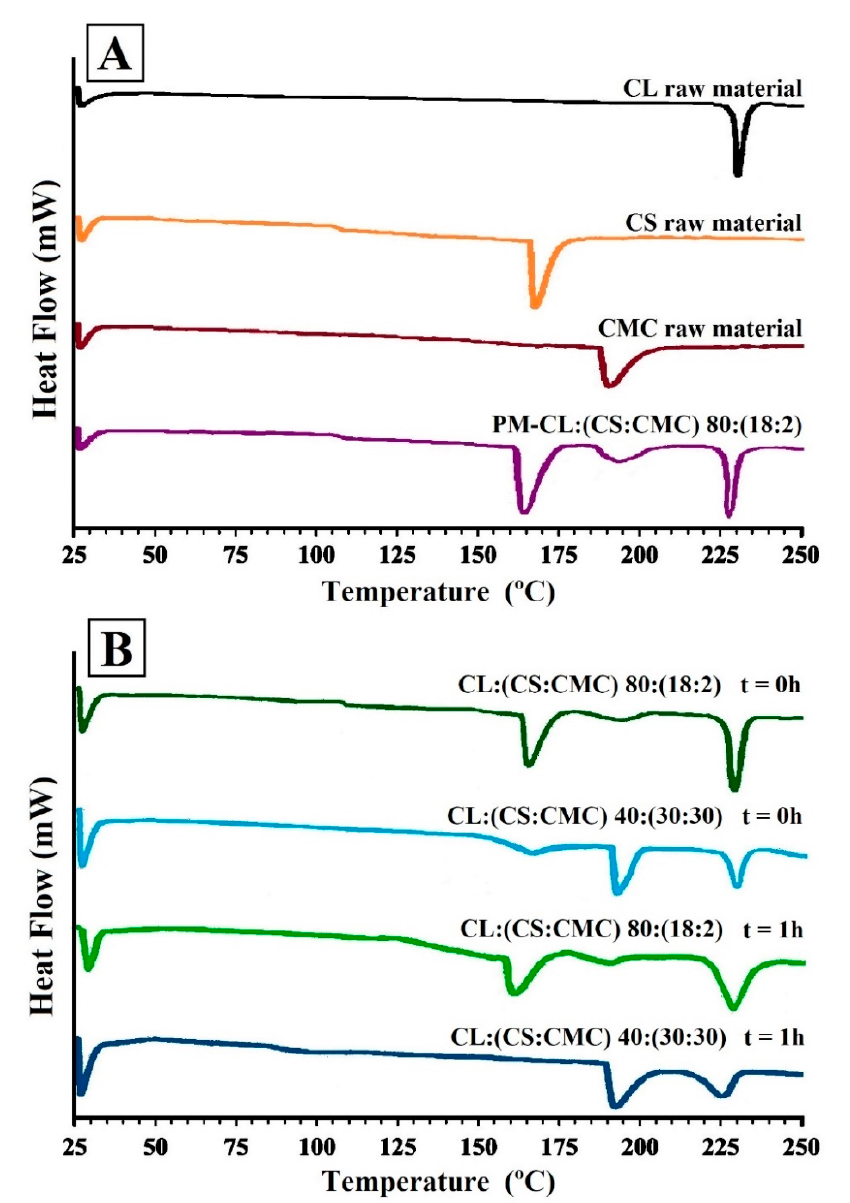
Figure 3. ( A ) DSC thermograms of clarithromycin (CL), chitosan (CS), carboxymethyl cellulose (CMC), and physical mixture CL:(CS:CMC) 80:(18:2). ( B ) PEC tablets CL:(CS:CMC) 80:(18:2) and CL:(CS:CMC) 40:(30:30) at 0 h and after 1 h in dissolution medium (pH 4.2). After 1 h in the dissolution medium (acetate buffer, pH 4.2), the PEC tablets with low CS:CMC proportions, CL:(CS:CMC) 80:(18:2), showed a slight shift in the